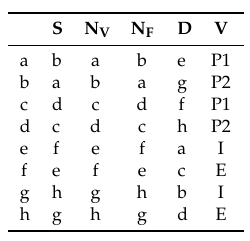
Figure 12. Euler operators: MEV/KEV, MVE/KVE, MZEV/KZEV, MEF/KEF (a, b—new half-edges). Euler operators do not check if input parameters are valid. For example, usually it is expected that two half-edges from the same face loop are given as an input for MEF. The result is a new edge,